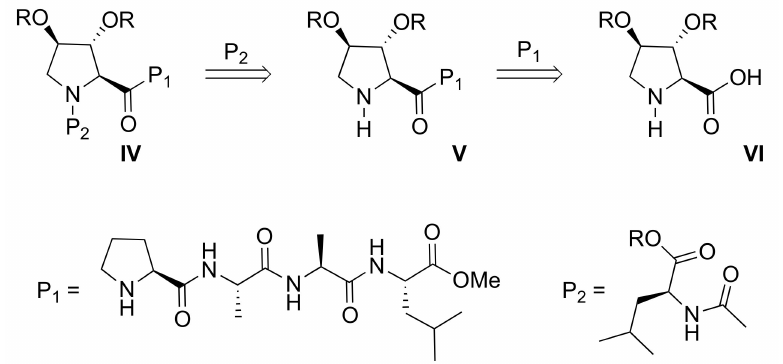
Figure 2. The proposed synthesis plan to prepare III involves subjecting the dihydroxylated proline (suitably protected) to the two peptide couplings shown in Scheme